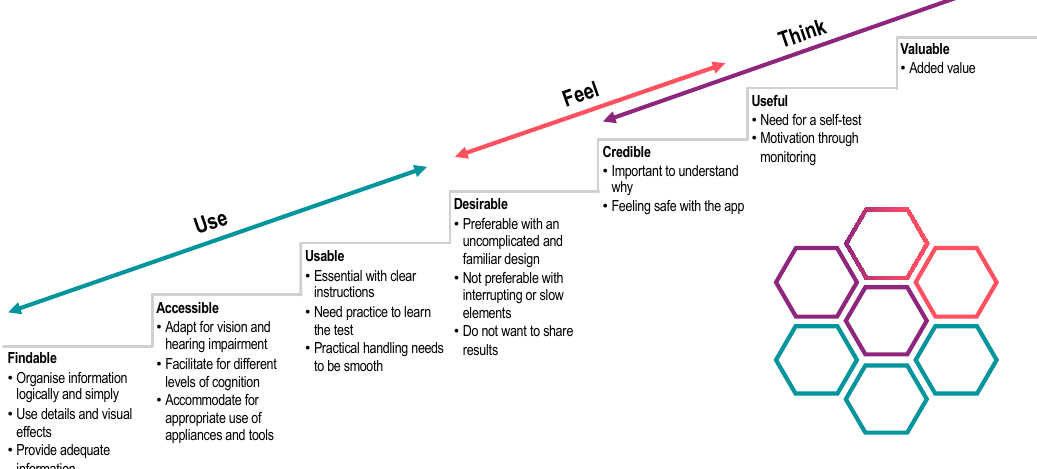
Figure 3. The user experience (UX) from the co-creation design process of the MyBalance app visualized as categories and subcategories in the UX Staircase model.